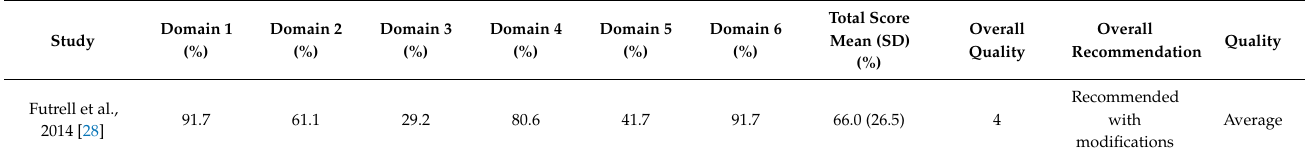
Table A6. The methodological quality assessment results of the guideline: AGREE II domain scores (%) and quality assessment.